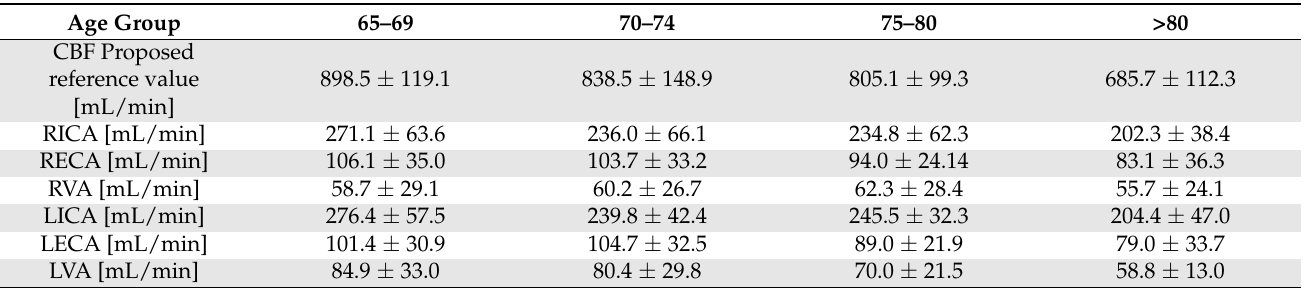
Table 2. Reference flow volume in extracranial arteries RICA, LICA—right and left internal carotid artery. RECA, LECA—right and left external carotid artery. RVA, LVA—right and left vertebral artery. Values are presented as the average ± standard